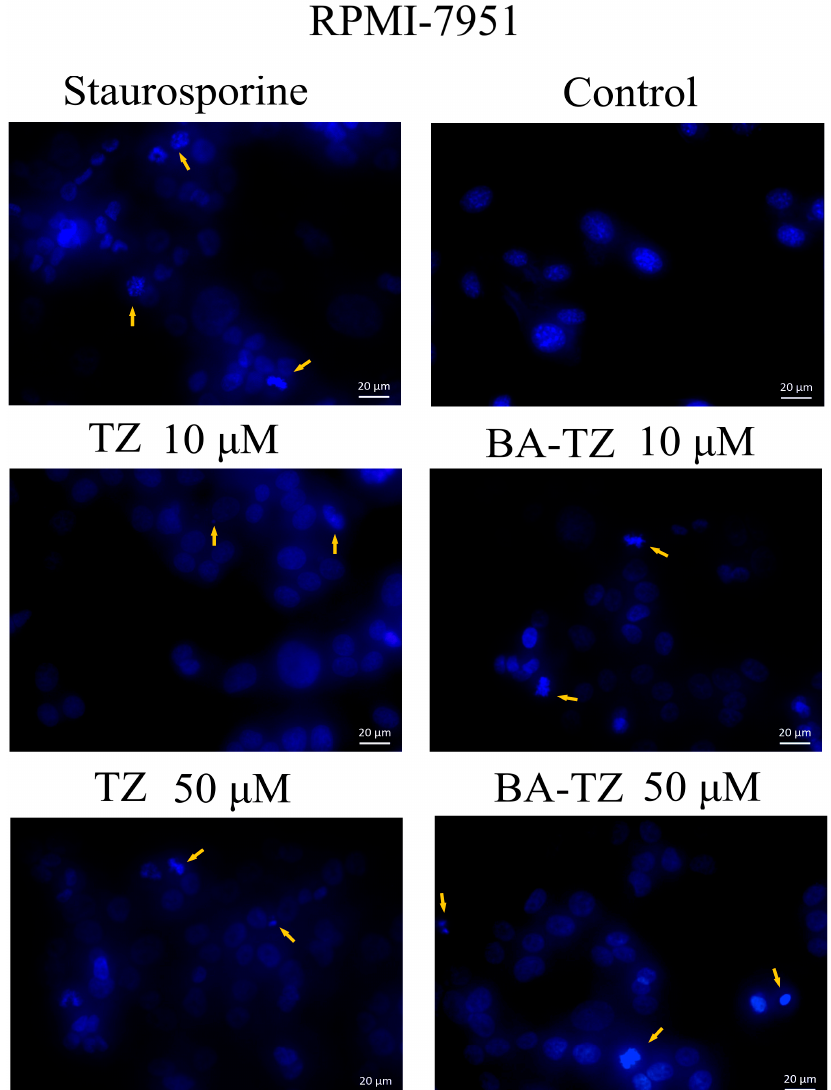
Figure 4. Morphological observation of RPMI-7951 cells using DAPI staining, after treatment with TZ and BA-TZ at 10 and 50 µ M for 24 h. The staurosporine solution (5 µ M) was used as positive control for apoptotic changes at the nuclear level. The yellow arrows represent signs of apoptosis, such as nuclear shrinkage, condensation, fragmentation and cellular membrane disruption.